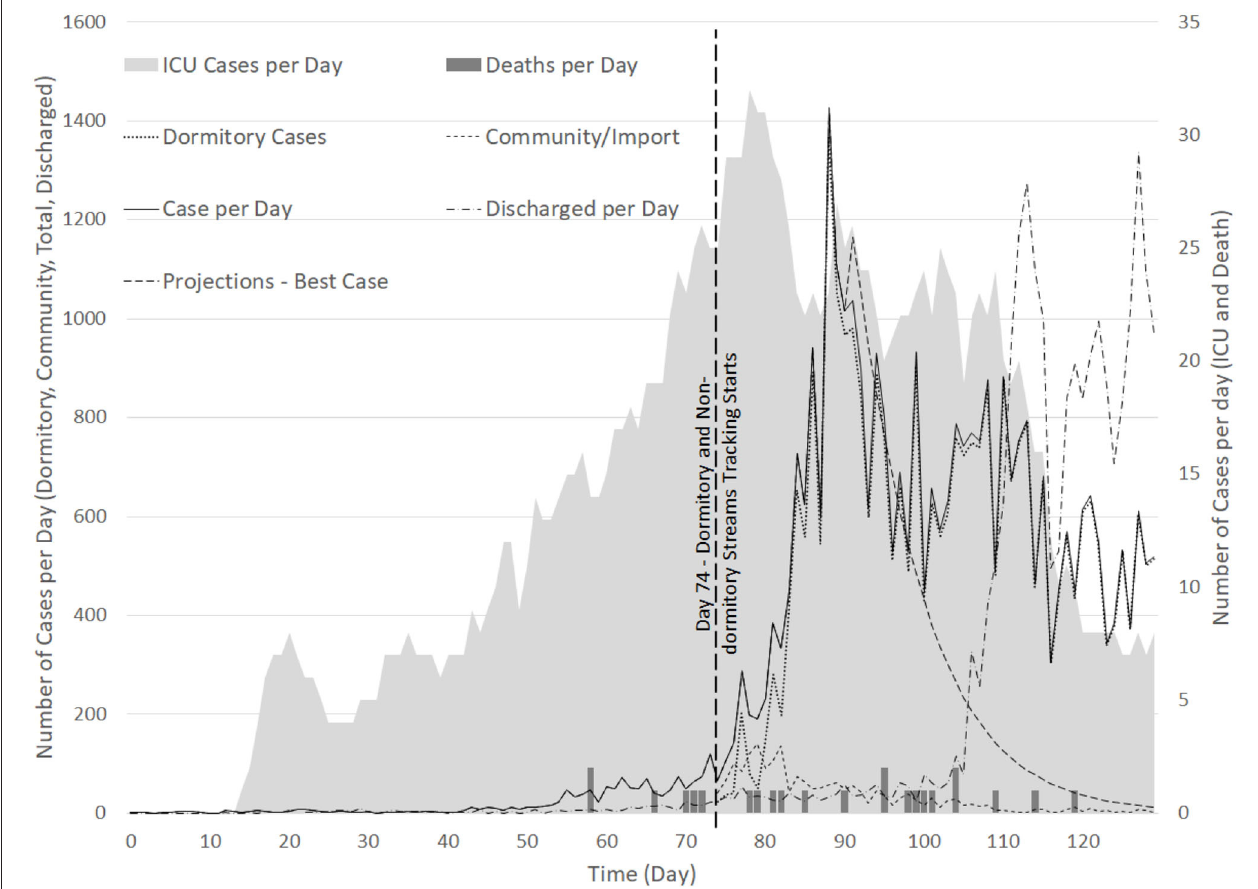
FIGURE 6 | Time series of cases detected per day for (1) Dormitory cases (from Day 74); (2) Community cases (from Day 74); (3) Total cases; (4) ICU cases, and; (5)